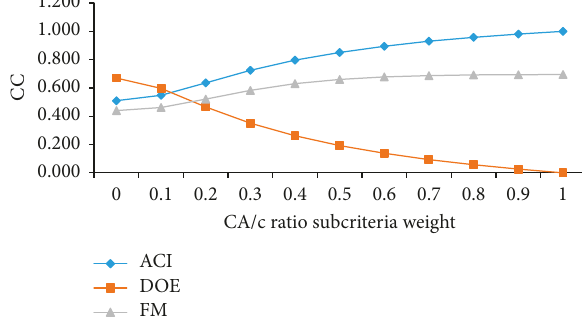
Figure 8: Sensitivity analysis of mix design methods with respect to CA/c ratio weight.